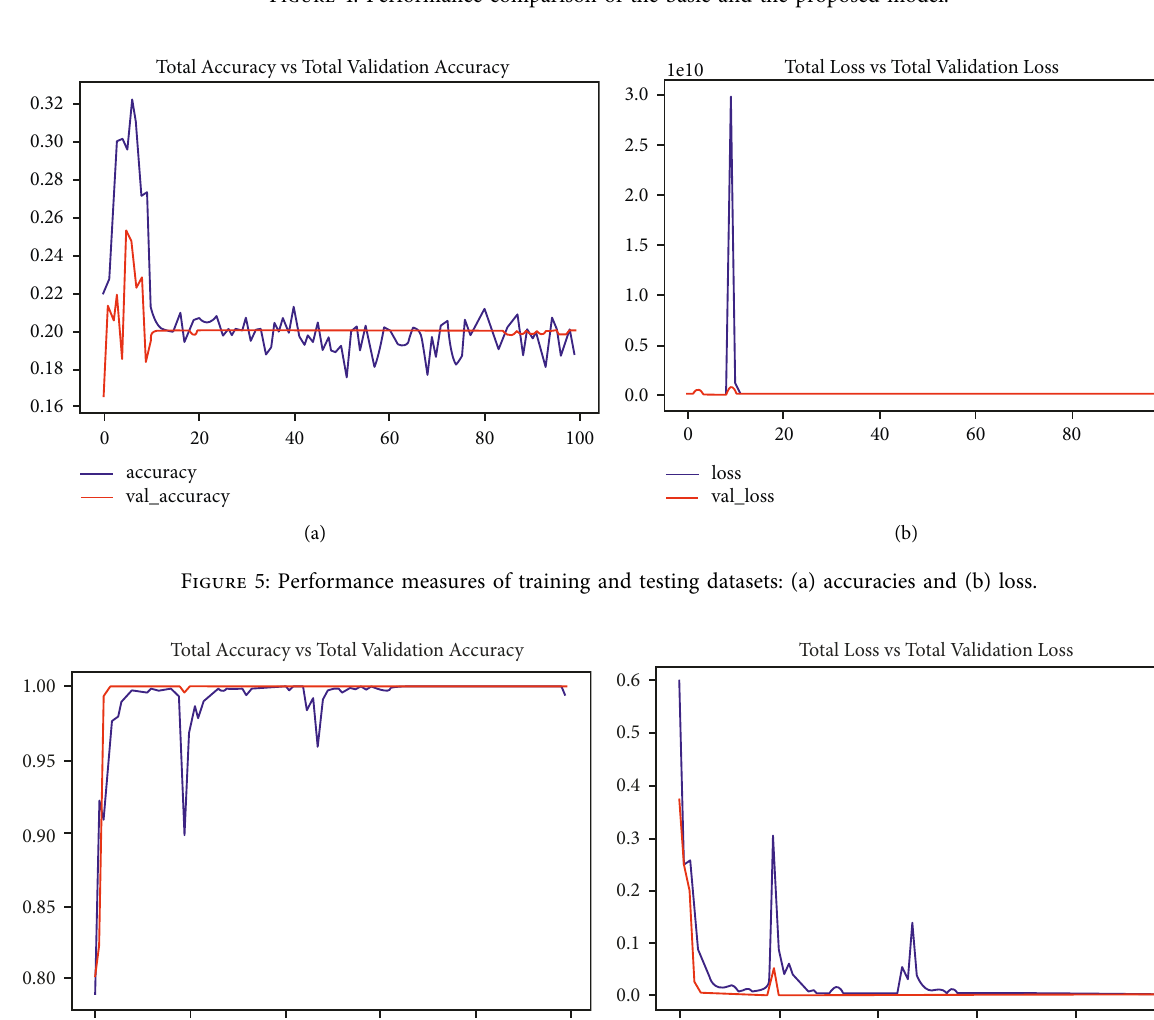
Figure 4: Performance comparison of the basic and the proposed